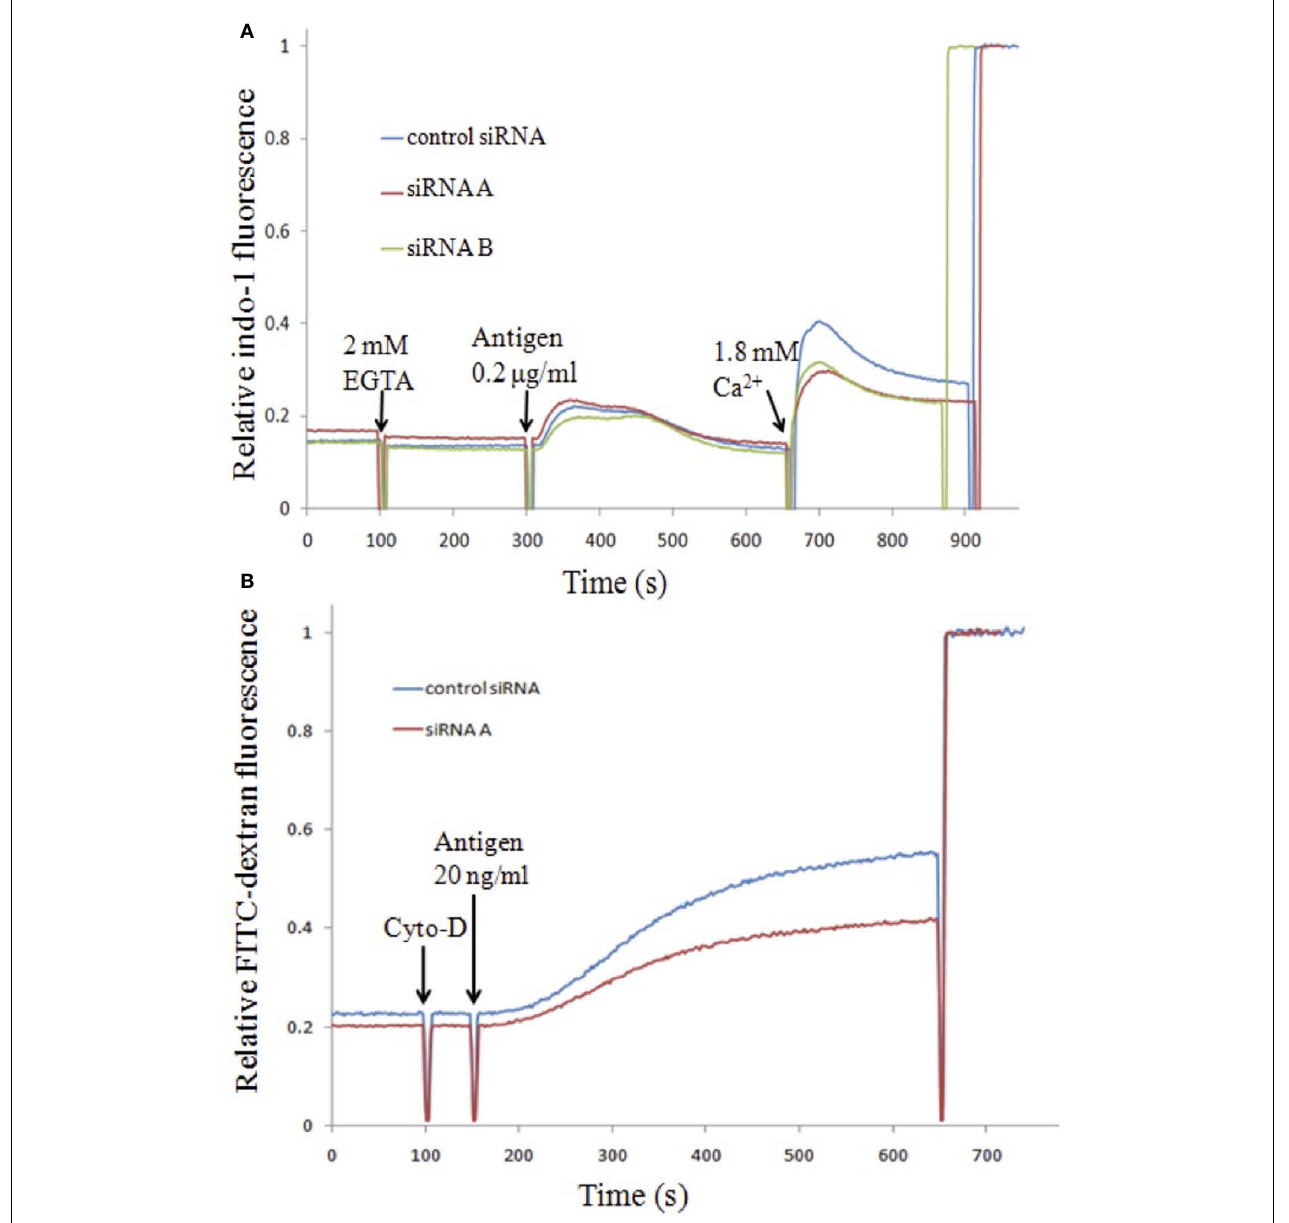
FIGURE 6 | Effects of siRNA knockdown of endogenous MARCKS protein on Ca 2 + (A) and degranulation (B) responses in RBL cells. (A) RBL cells transfected with irrelevant control siRNA or two different siRNA sequences specific for rat MARCKS (Gadi, 2012) were loaded with the [Ca 2 + ] indicator indo-1 before stimulating with antigen in the absence of extracellular Ca 2 +